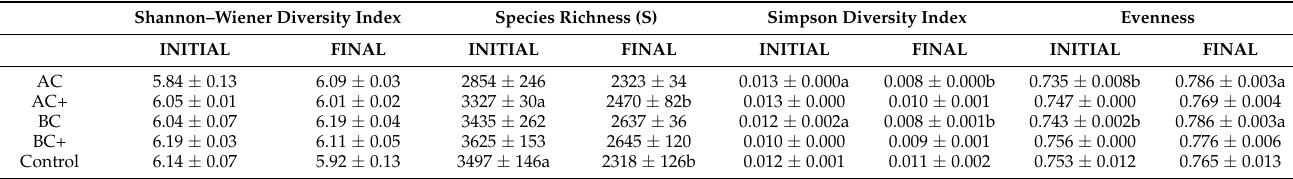
Figure 3. Relative abundance of top 10 soil bacterial phyla in control soil and amended soils at low (AC and BC soils) and high doses (AC+ and BC+ soils) at two different samplings. Table 1. Richness estimates and diversity indices (means ± SE) for 16S rRNA libraries of soils. For each parameter, different letters indicate a significant difference among initial and final sampling ( p < 0.05, ANOVA, Dunn’s post hoc Bonferroni-corrected p -values) when they exist.